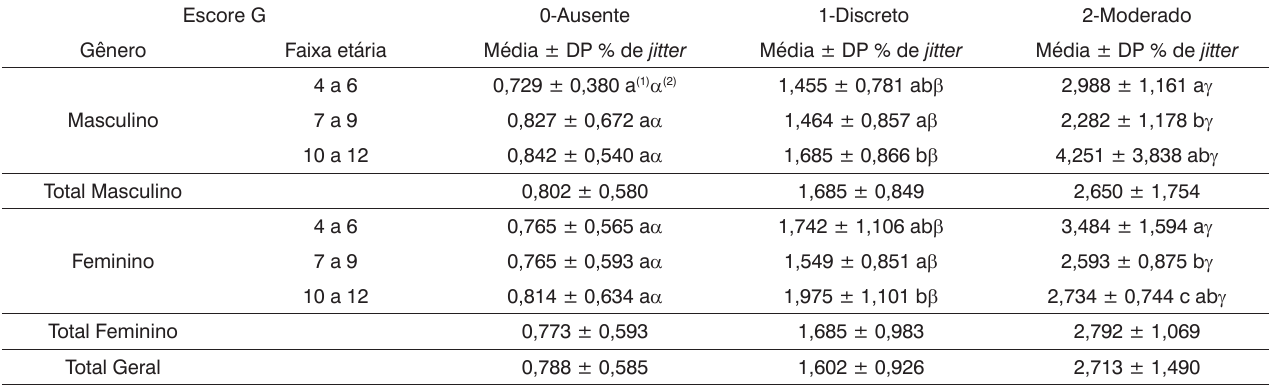
Tabela 7. Valores médios e desvio padrão (DP) da % de jitter e correlação com o escore do parâmetro G da escala GRBASI, o gênero e a faixa etária (em